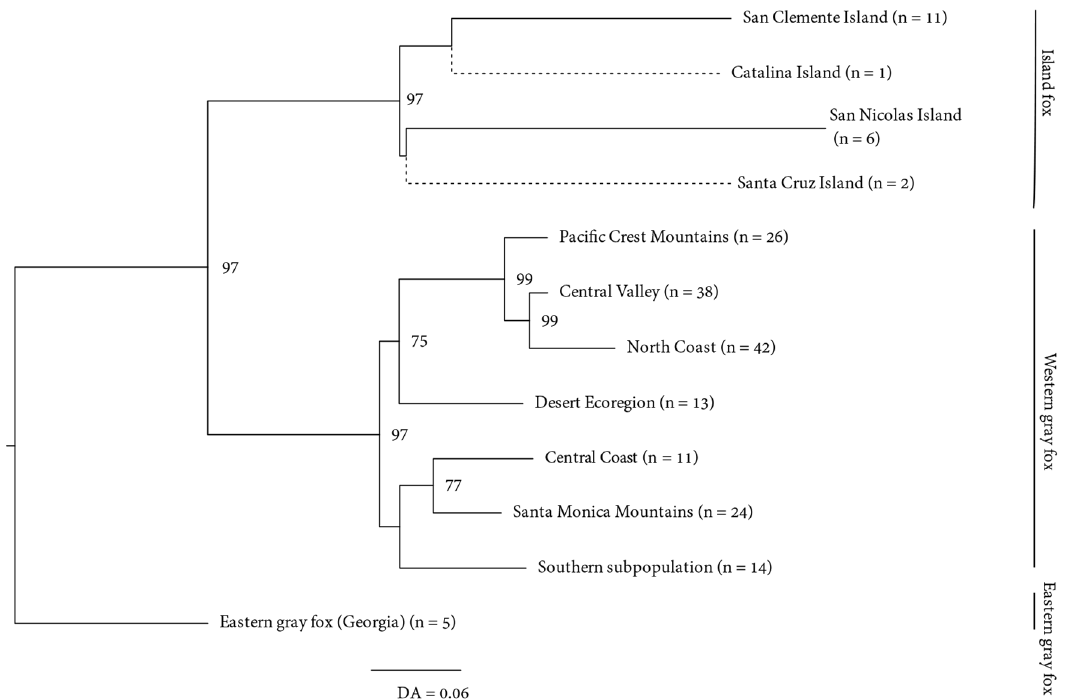
Figure 5. Neighbor-joining population tree illustrating reciprocal monophyly between a group of 4 Island fox ( Urocyon littoralis ) populations versus 7 western gray fox ( U. cinereoargenteus ) populations, rooted to an eastern gray fox population outgroup. Branch lengths are based on Nei’s genetic distance ( D A ) [36] calculated from 20 microsatellite loci and 999 bootstrap replicates. Only bootstrap values >65% are shown. Bootstrap values were calculated without Santa Catalina and Santa Cruz island populations included because of low sample size.